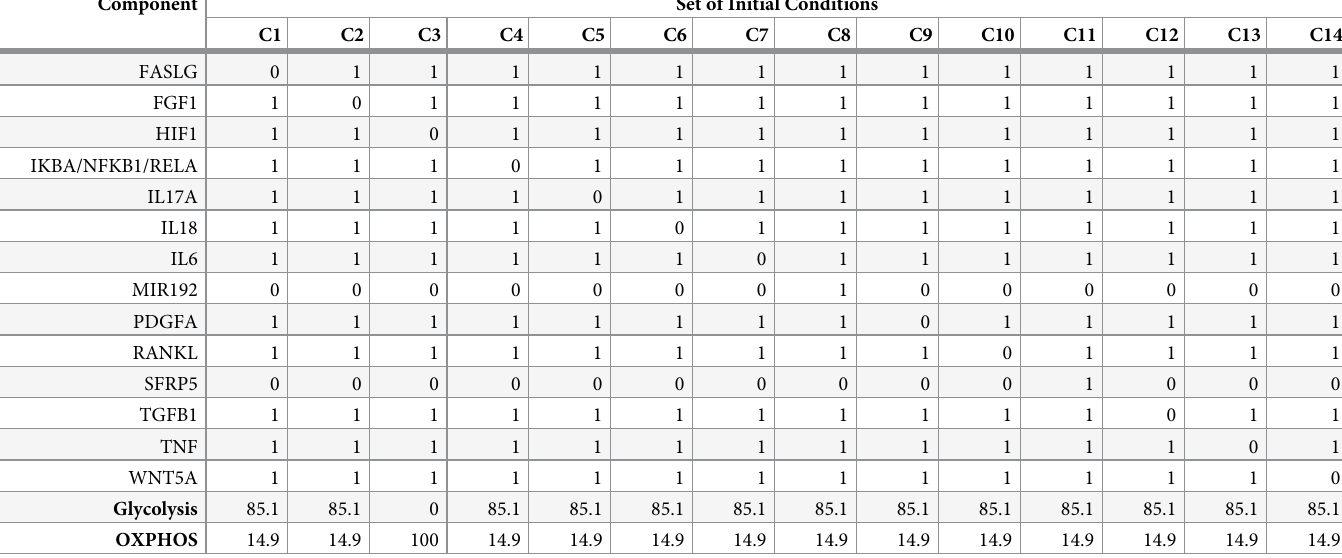
Table 4. Regulatory knock-out/knock-in simulations’ set of initial conditions along with their FBA results in terms of total cellular ATP production from glycolysis and OXPHOS. Each component’s value initially set to 1/0 in RASF-specific conditions was alternatively set to 0/1 while the others remained at RASF-specific values. Component Set of Initial Conditions FASLG